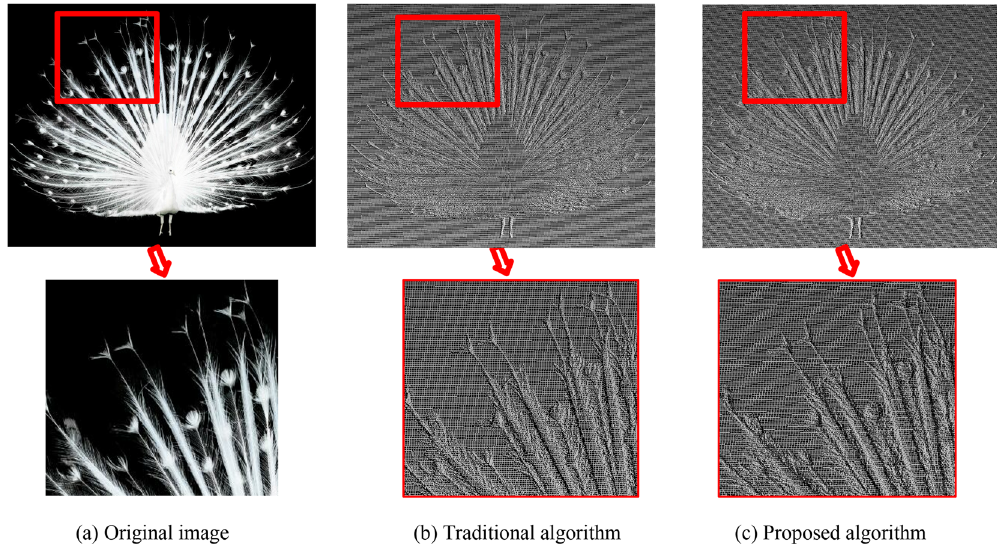
Figure 13. Point cloud comparison images of the “peacock pattern”.